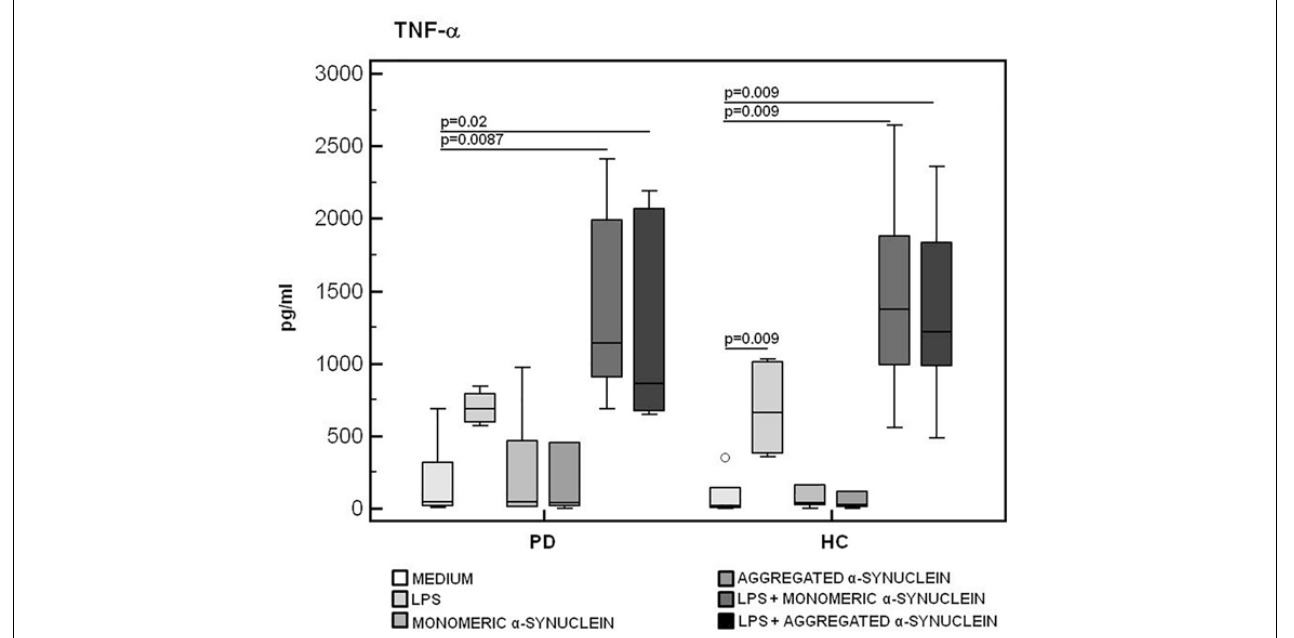
FIGURE 6 | TNF- α proinflammatory cytokine production by monomeric or aggregated α -synuclein–stimulated cells of PD and HC subjects. TNF- α concentration was evaluated by enzyme-linked immunosorbent assay in supernatants of unstimulated, LPS-stimulated, monomeric α -synuclein–stimulated, aggregated α -synuclein–stimulated, LPS-primed and monomeric α -synuclein–stimulated, or LPS-primed and aggregated α -synuclein–stimulated cells of 15 Parkinson disease (PD) patients and 15 healthy controls (HC). Summary results are shown in the bar graphs. The boxes stretch from the 25th to the 75th percentile; the line across the boxes indicates the median values; the lines stretching from the boxes indicate extreme values.